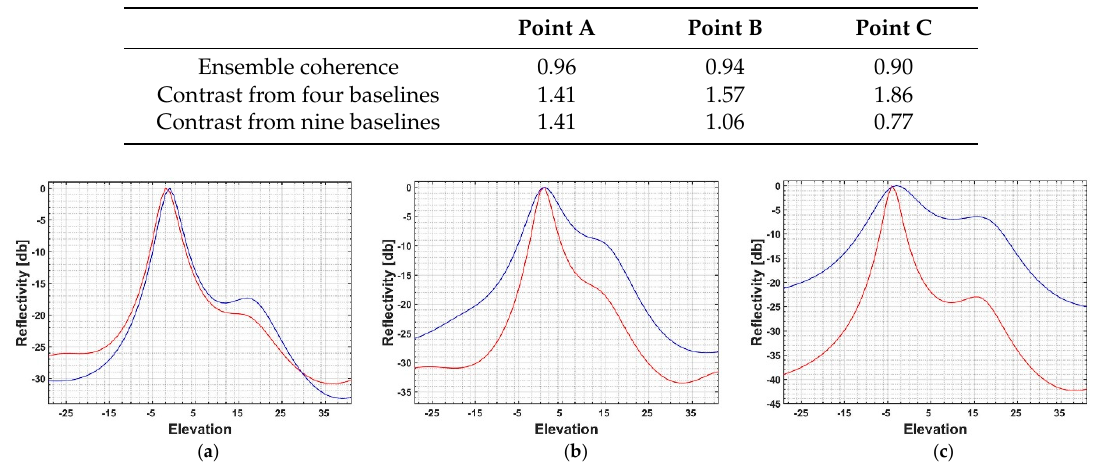
Figure 5. The polarimetric reflectivity of the three selected cells in Figure 4, with 4 (red) and 9 (blue) data stacks: ( a ) point A, ( b ) point B, ( c ) point C.